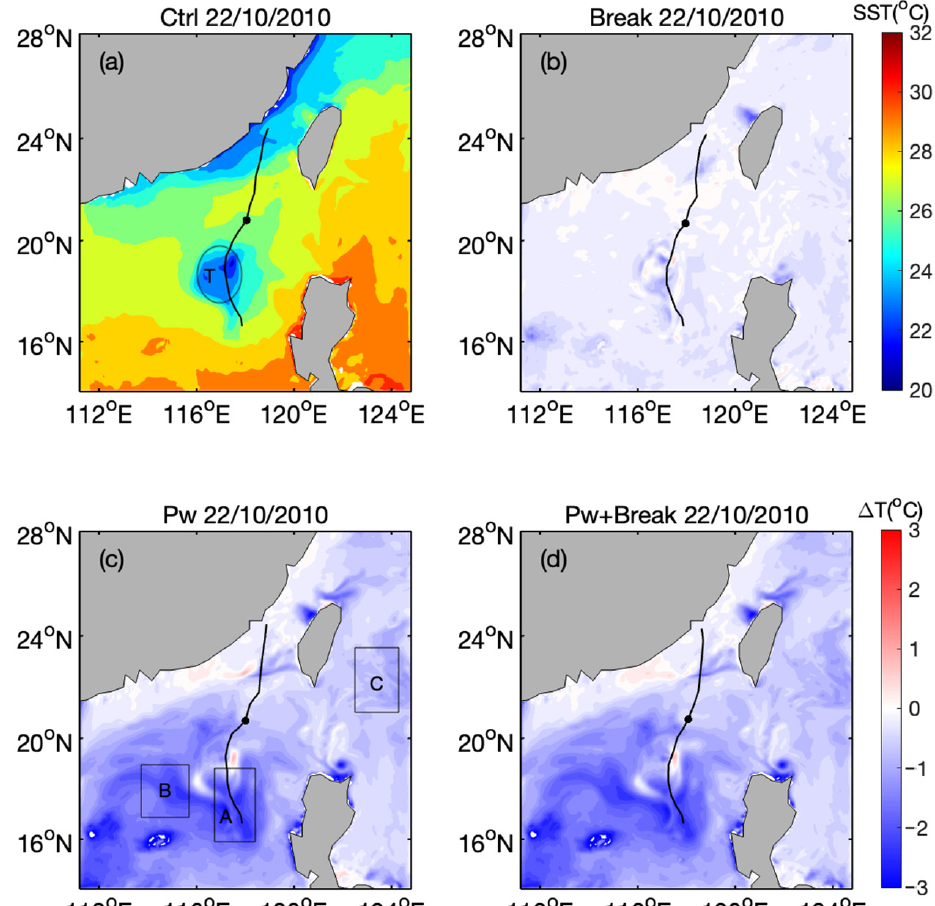
Figure 3. Simulated daily mean SST in different numerical experiments on 22 October 2010. ( a ) SST in the control experiment excluding wave-induced mixing. ( b – d ) Deviations of SST compared with the control experiment for each of the three experiments including mixing owing to surface waves (i.e., considering only the mixing owing to wave breaking, only the mixing owing to wave orbital motion, and both these two factors). The black dot indicates the position of Megi’s center at 00:00 UTC on 22 October 2010. The black line represents Megi’s track. The ellipse marked with “T” in the panel ( a ) represents the classic cold tail zone behind Megi’s center. Text boxes marked with “A”, “B”, and ”C” in the panel ( c ) display three different and representative analysis areas.